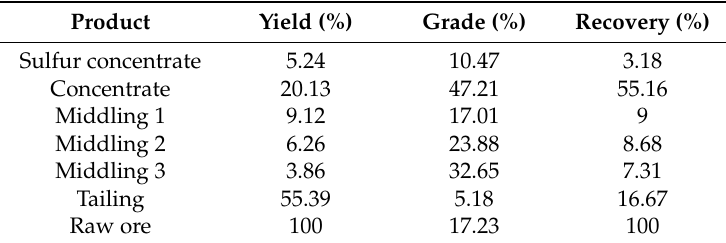
Table 8. The results of open-circuit test of attrition-scrubbing samples.